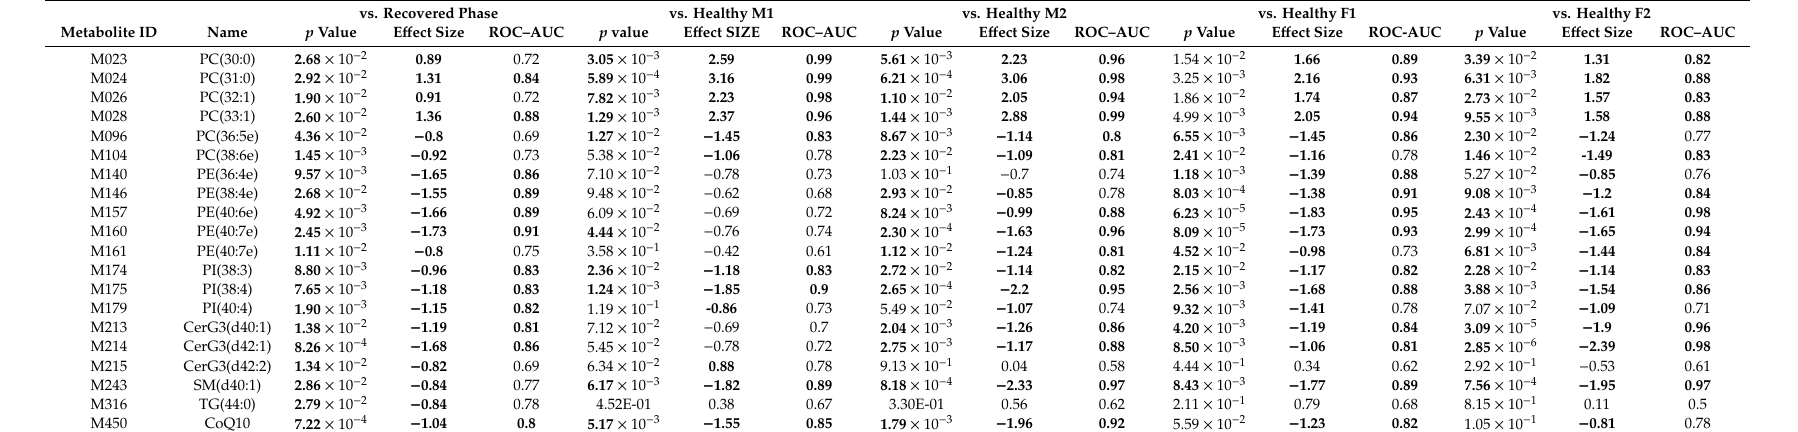
Table 4. Specific lipids altered in cholestatic-type